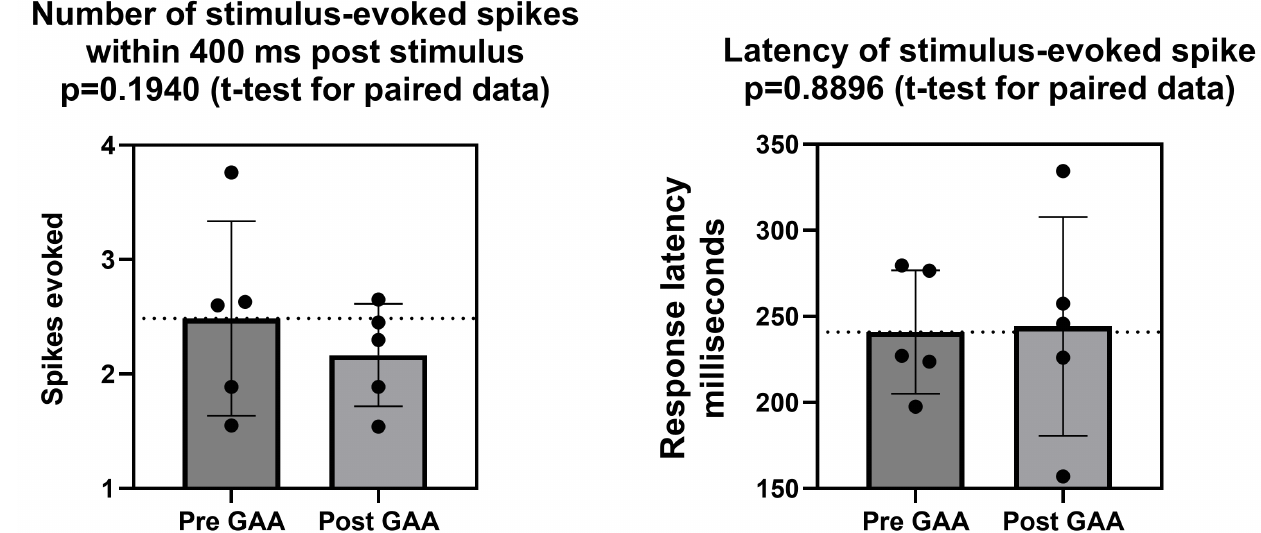
Figure 6. Effects of 10 µ M Guanidinoacetic Acid (GAA) on number and latency of evoked spikes in neocortical networks. Bars and lines represent mean and standard deviation. Symbols represent individual experiments. See text for additional explanations.